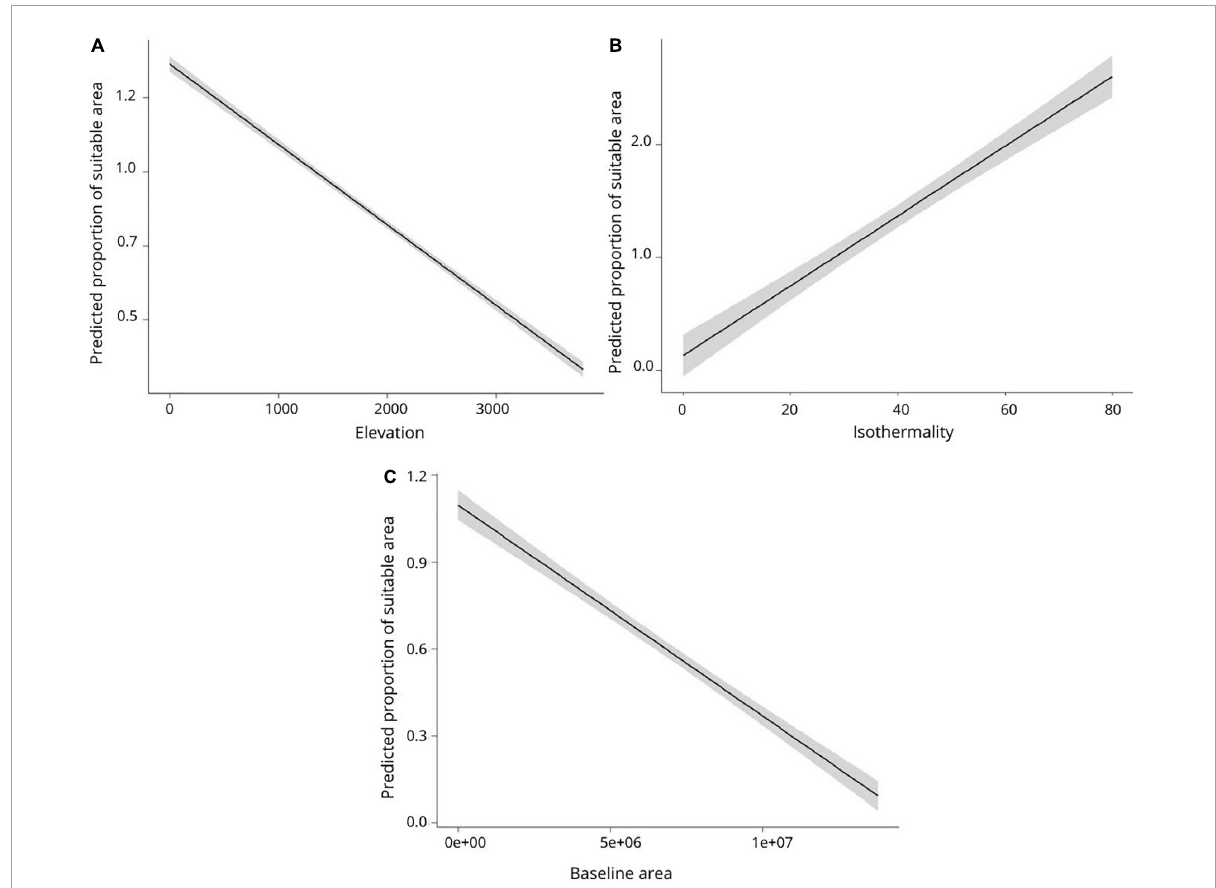
FIGURE3 Relationship between the proportion of climatically suitable areas and elevation (A) , isothermality (B) , and baseline area (C) . Values above one indicate gain of suitable area. The gray area represents confidence intervals (95%).